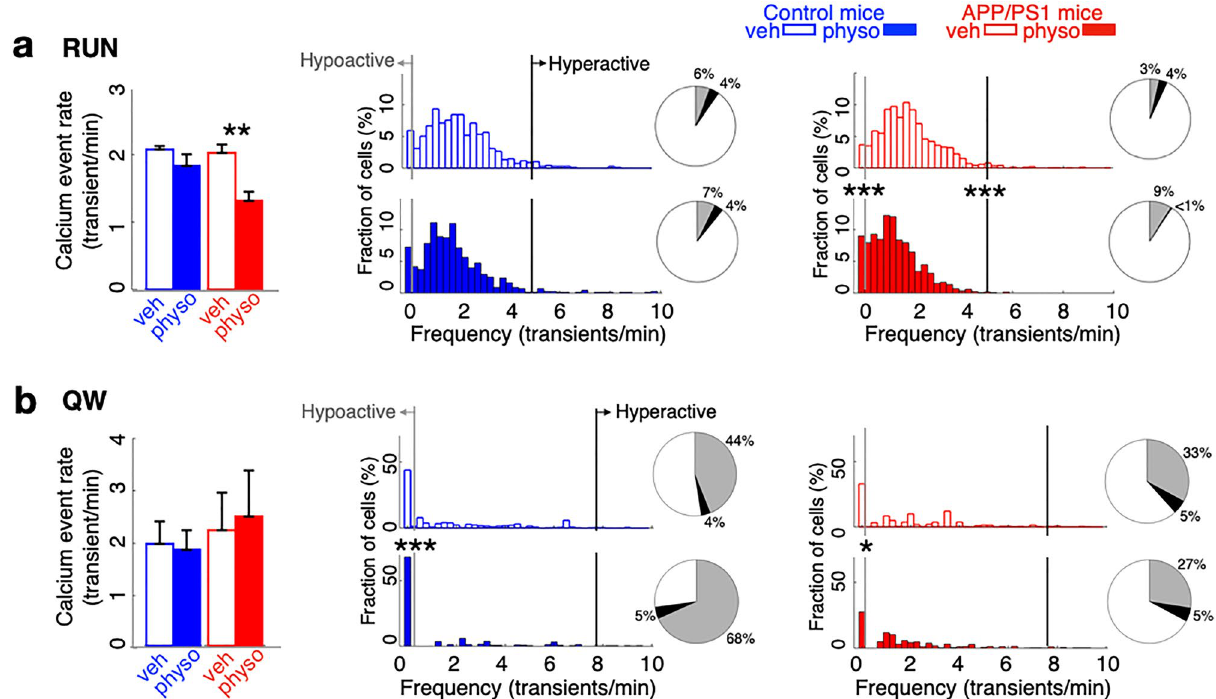
Figure 4. Acetylcholinesterase inhibitor-mediated rescue of Aβ-induced aberrant calcium activity is partial and behavior dependent. ( a ) Compared to treatment with vehicle, physostigmine injection (i.p.) reduced calcium event rates during RUN in APP/PS1 mice but not in control mice. In control mice, physostigmine had no effect on the proportion of hypoactive or hyperactive neurons. In APP/PS1 mice, physostigmine reduced the proportion of hyperactive neurons and increased the proportion of hypoactive neurons. ( b ) In quiet wakefulness (QW), physostigmine injection had no effect on calcium event rates compared to treatment with vehicle in APP/ PS1 or control mice. In control mice, physostigmine increased the proportion of hypoactive cells. In contrast, in APP/PS1 mice physostigmine decreased the proportion of hypoactive cells. Grey: hypoactivity (< 0.25 transients/min); Black: hyperactivity (> 2 SD of mean calcium event rates under vehicle). * p < 0.05; ** p < 0.01; *** p < 0.001, paired t-tests, χ 2 tests; control n = 5 mice, n = 674 cells; APP/PS1 n = 5 mice, n = 1110 cells. Data are represented as mean ±